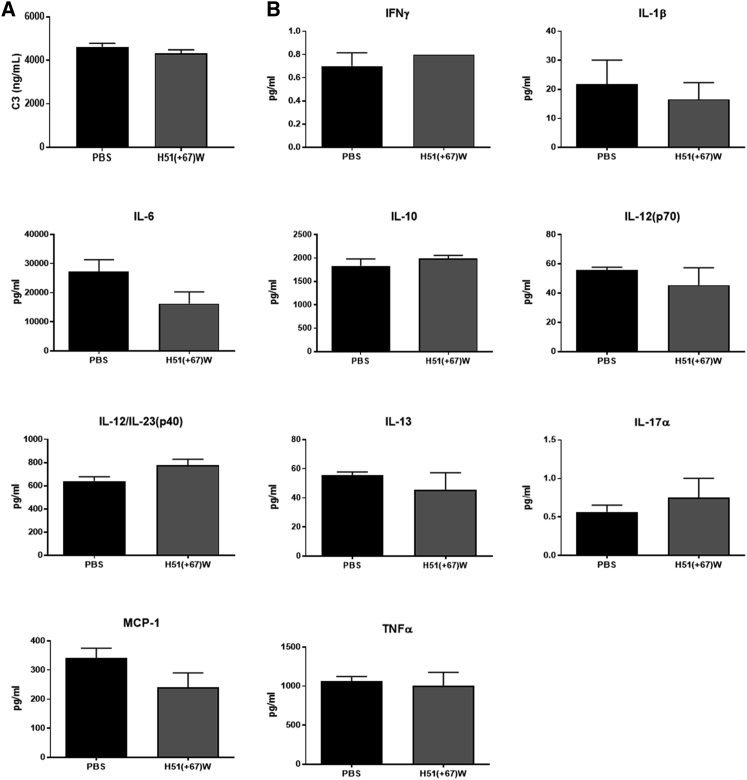
High Dose of H51(+67)W Does Not Affect Total C3 and Cytokine Levels in mdx52 Mice(A) Mouse serum was collected 1 h after the first injection at 200 mg/kg, and mouse C3 was analyzed by ELISA (PBS n = 3, H51(+67)W (n = 4). (B) Mouse serum was collected 1 h after the first injection at 200 mg/kg, and cytokine levels were analyzed using a multiplex assay kit (PBS n = 3, H51(+67)W n = 4). Results are expressed as mean ± SEM; p > 0.05 for all groups.